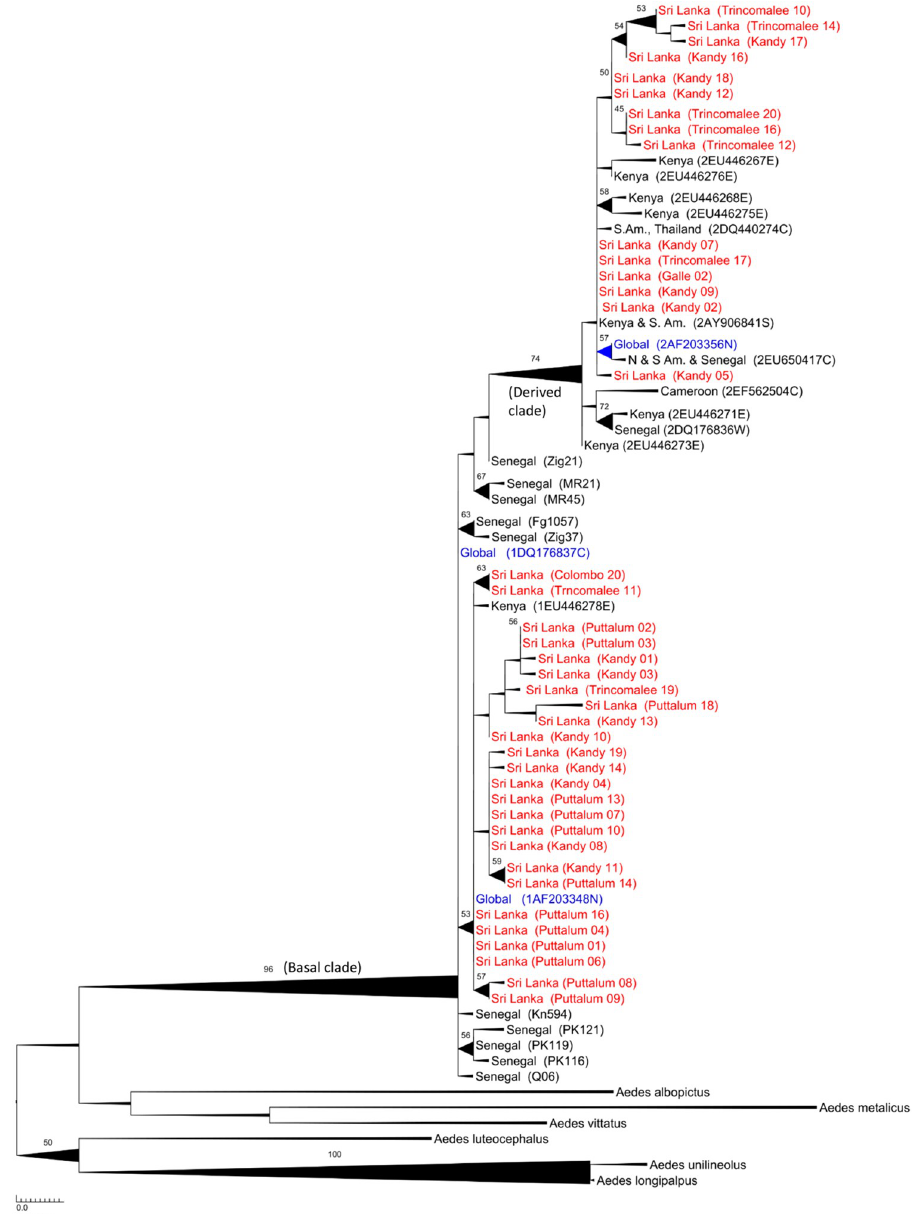
Fig 2. Bootstrapped Maximum Likelihood tree derived using the ND4 gene. The “basal” clade has bootstrap support of 96% and contains the West African collections at its base. The “derived” clade (bootstrap support = 74%) has both East and West African collections at its base, global collections (AF203356) and many East African sequences from Kenya. All Sri Lankan collections appear in red and are present in both clades. Information in parentheses indicate the collection site and its unique identification number in the aligned dataset. The thickness of lines is proportional to the bootstrap support. Maximum likelihood branch lengths are proportional to the number of nucleotide substitutions per